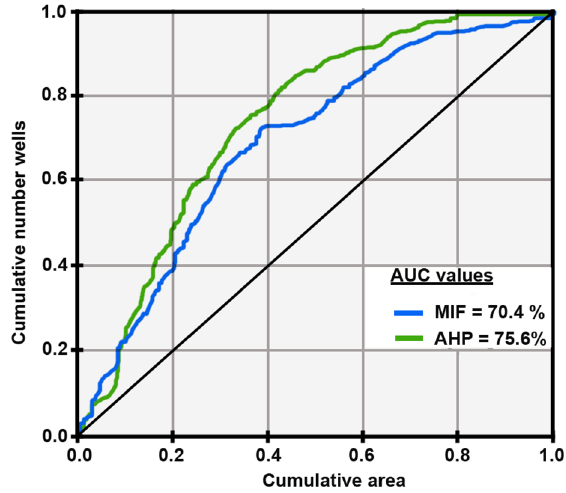
Figure 10. Average of Receiver Operating Characteristic (ROC) curves for AHP and MIF methods.